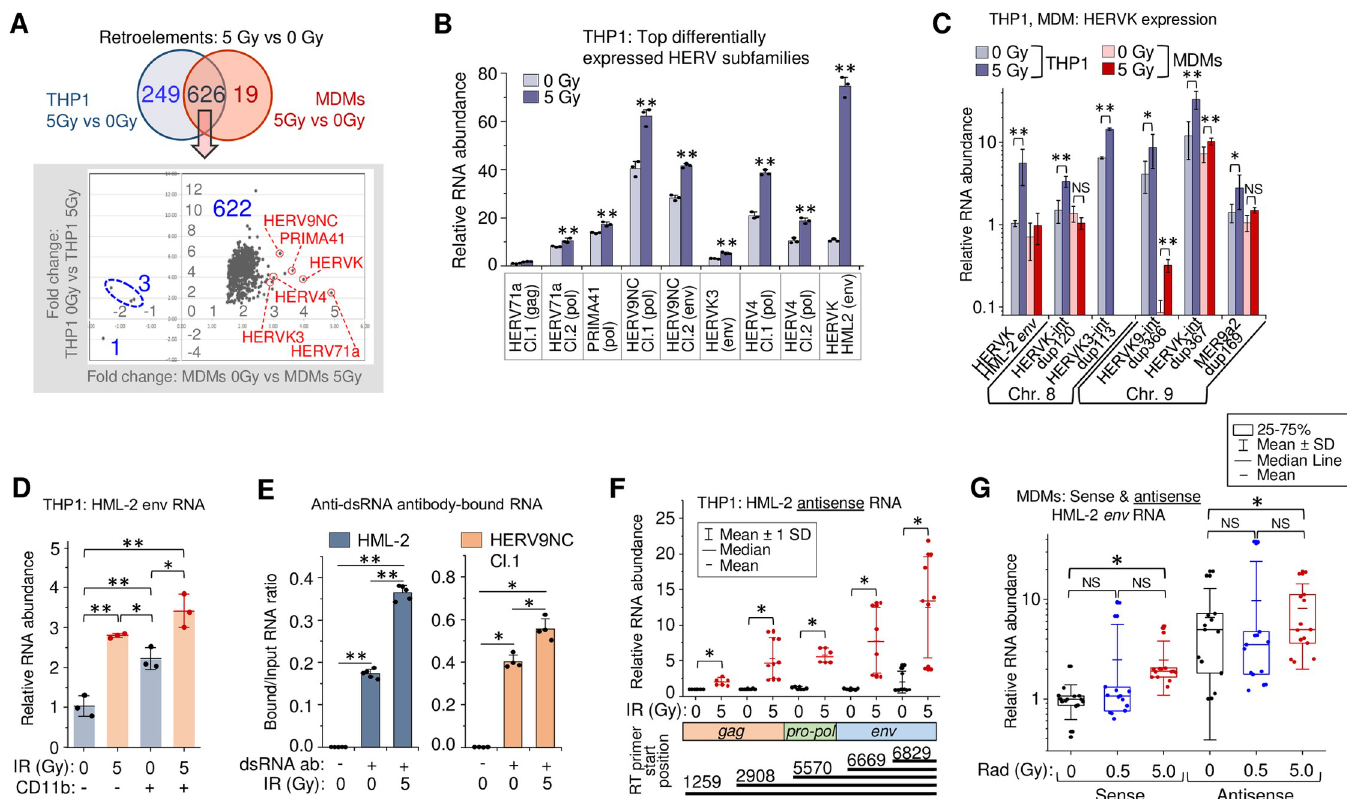
Fig 4. Gamma radiation activates HERV transcription in primary human MDMs and THP1 cells. ( A ) Top : Venn diagram of differentially expressed retroelements and HERVs identified between irradiated vs. control THP1 cells or MDMs. Bottom : expression fold changes detected for the common set (626 features) shown on the upper Venn diagram. ( B ) Expression of six HERV clades, identified upregulated by RNA-Seq in both irradiated THP1 cells and MDMs (panel A, red circles), measured by RT-qPCR at 48h post-exposure to 5 Gy γ IR dose. Primers were designed for the alignments within the clusters identified across gag , pol or env genes of the sequences within the clades. Error bars: ± SD of three independent biological replicates. ( C ) Expression, measured by RT-qPCR, of randomly selected differentially expressed HERVK in THP1 cells (grey columns) and primary MDMs (red columns), 48h post-irradiation. Error bars: ± SD of three independent biological replicates. ( D ) Transcription of HERVK HML-2 env in response to 5 Gy γ IR dose, measured by RT-qPCR at 48h post-exposure in CD11b-positive and negative THP1 cells, separated by sorting flow cytometry. Only viable, DAPI-negative cells were analyzed; box plot of n = 3 is shown. Error bars: ± SD of three independent biological replicates. ( E ) Ratio of HERV RNA bound to anti-dsRNA antibodies to total RNA input: HML-2 (left) and HERV9NC Cl.1 pol (right) from 5 Gy γ IR exposed and unexposed THP1 cells. RT- qPCR of RNA-IP (RIP) complexes with rJ2 and 9D5 antibodies, 48h post-irradiation. Error bars: ± SD of five (HML-2) or four (HERV9NC) independent biological replicates; in panels B-E, � p < 0.05, �� p < 0.01. ( F ) Relative count of HERVK HML-2 antisense RNA identified with antisense strand-specific reverse transcription primers targeting regions in the env , pol and gag genes, and quantitated by qPCR. Error bars: ± SD of at least 6 independent biological replicates. ( G ) Relative count of the sense and antisense transcripts of HERVK HML-2 measured by RT-qPCR using env- specific primers, 48h after irradiation of MDMs. MDMs were differentiated with M-CSF from PBMCs isolated from 5 donors. Box plot of n = 15 is shown. In panels F and G, � p < 0.05, NS non-significant, paired Wilcoxon test.